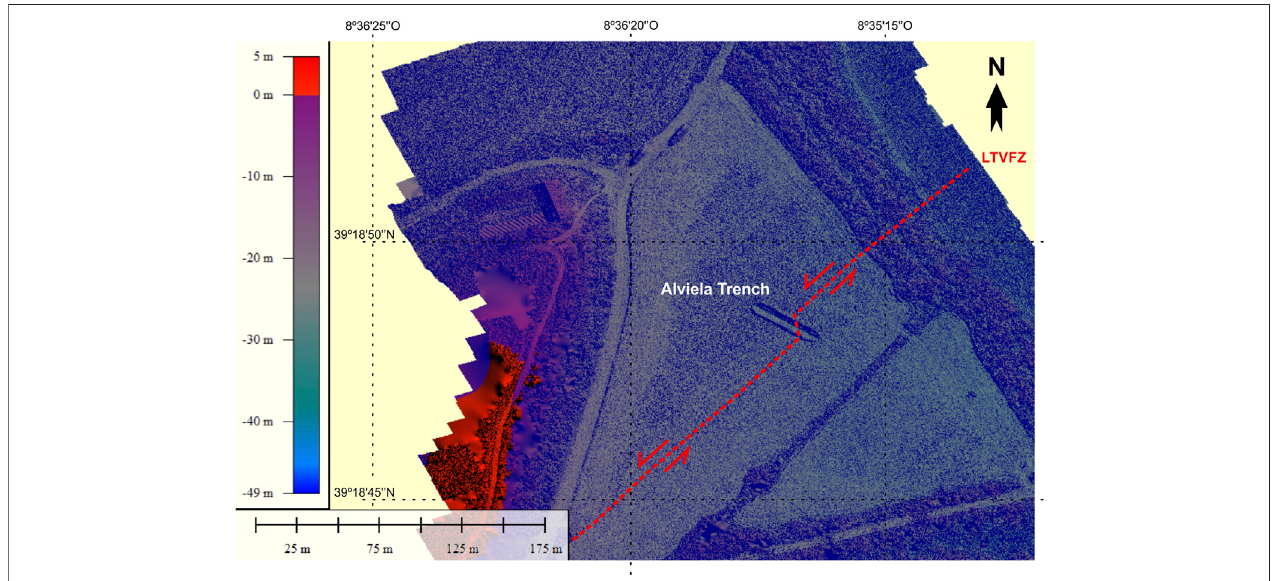
FIGURE 6 | Very high resolution DSM of the Alviela site, showing the trench and the direction of the fault within the trench, which is different from the general direction of the fault scarp.